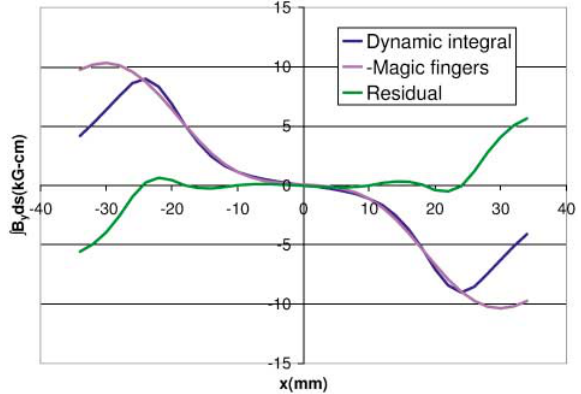
FIG. 11. (Color) Field integral without (top) and with (bottom) magic